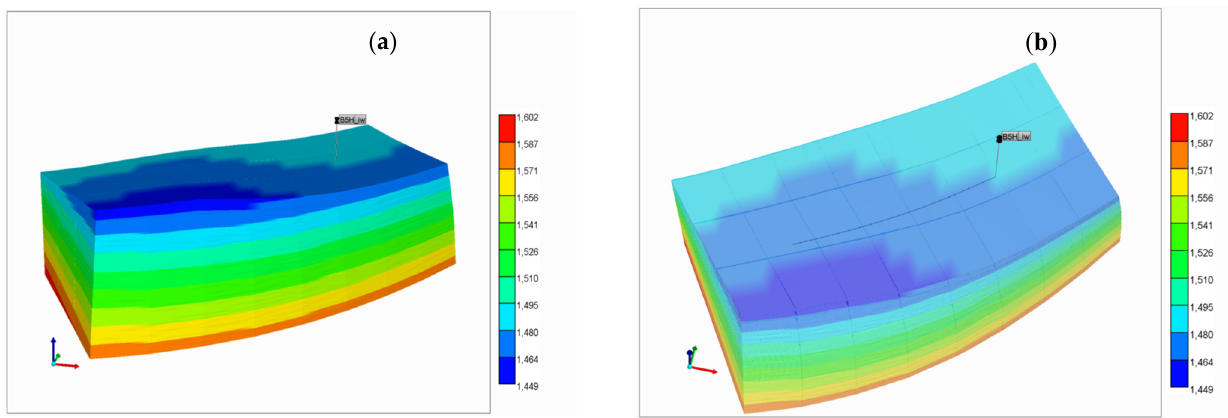
Figure 2. The established three-dimensional reservoir model and the horizontal well model: ( a ) three-dimensional reservoir model; ( b ) the horizontal well model.